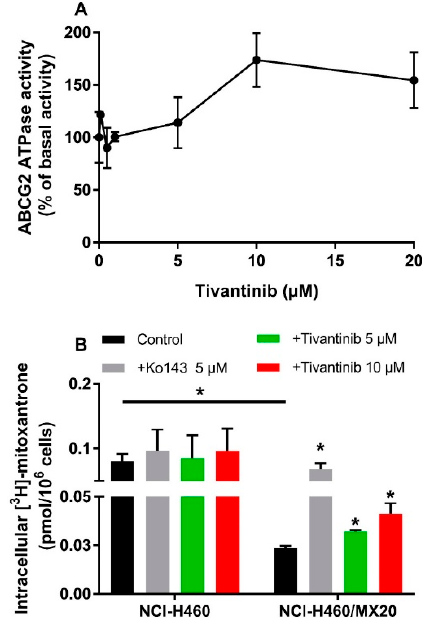
Figure 2. E ff ect of tivantinib on the ATPase activity of ABCG2 and accumulation of [ 3 H]-mitoxantrone. ( A ) Tivantinib stimulates the ATPase activity of the ABCG2 transporter; ( B ) The e ff ect of tivantinib on the intracellular accumulation of [ 3 H]-mitoxantrone in NCI-H460 and NCI-H460 / MX20 cells after 2 h treatment. Data are expressed as the mean ± SD from a representative of three independent experiments. * p < 0.05, compared with control group.